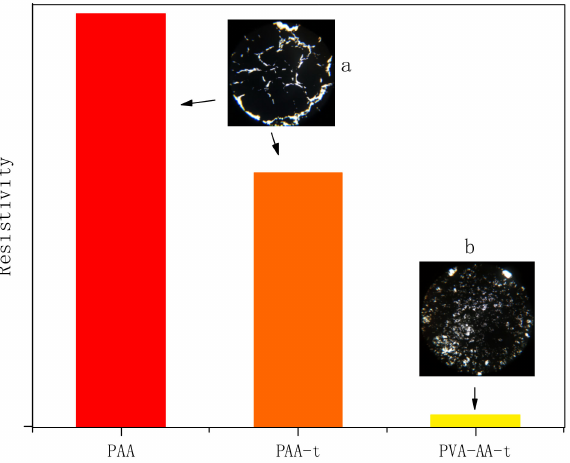
Figure 12. Resistivity of graphene electrode sheet. ( a ) PAA and PAA-t; ( b )